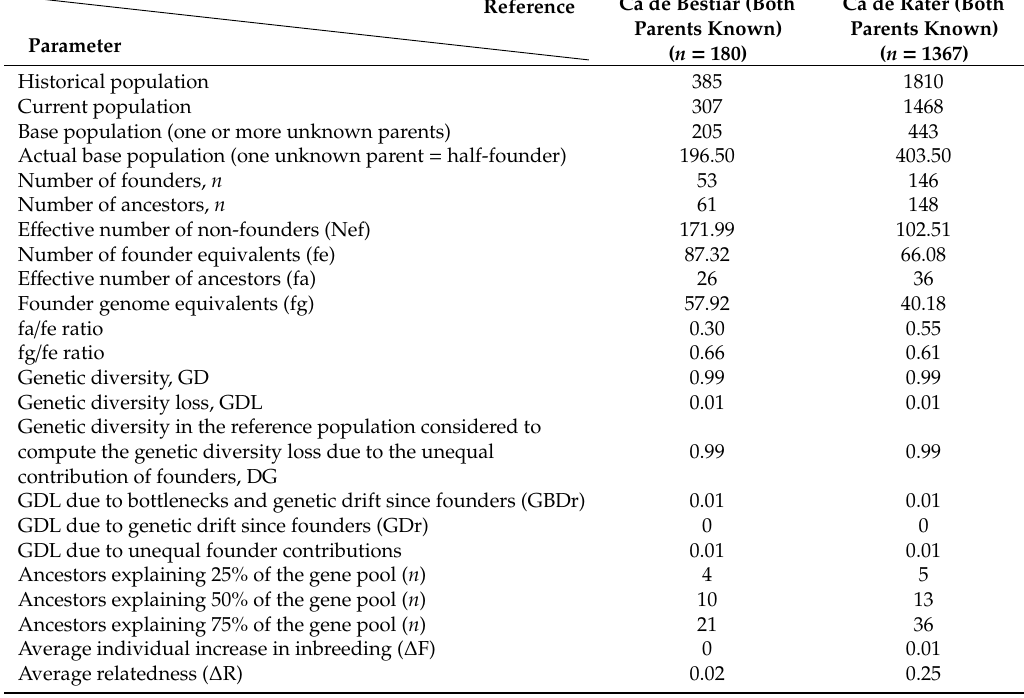
Table 3. Summary of the measures of genetic diversity, genetic diversity loss, and analysis of the probabilities of genetic